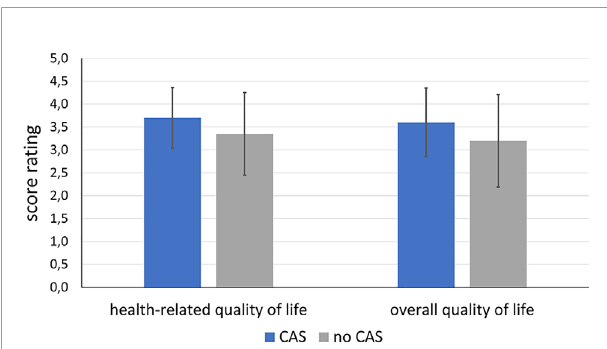
FIGURE 11 | Comparison of health-related and overall quality of life of the patients of the intervention group treated using CAS compared to the control group treated conventionally without